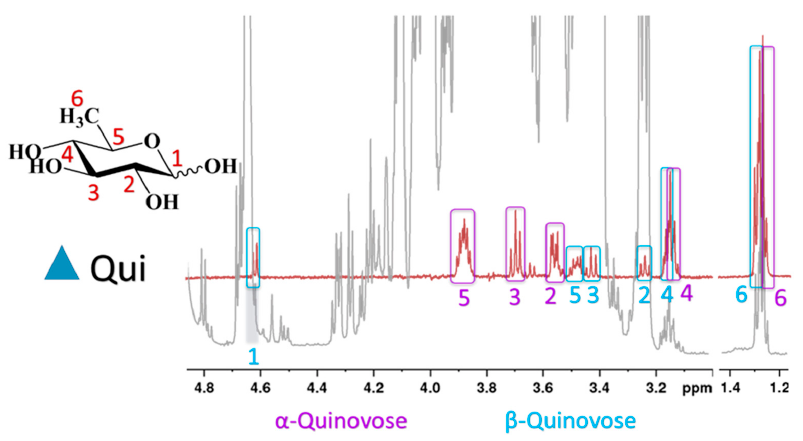
Figure 1. Selective TOCSY spectrum of quinovose (red line) and 1 H spectrum of honey (grey line).